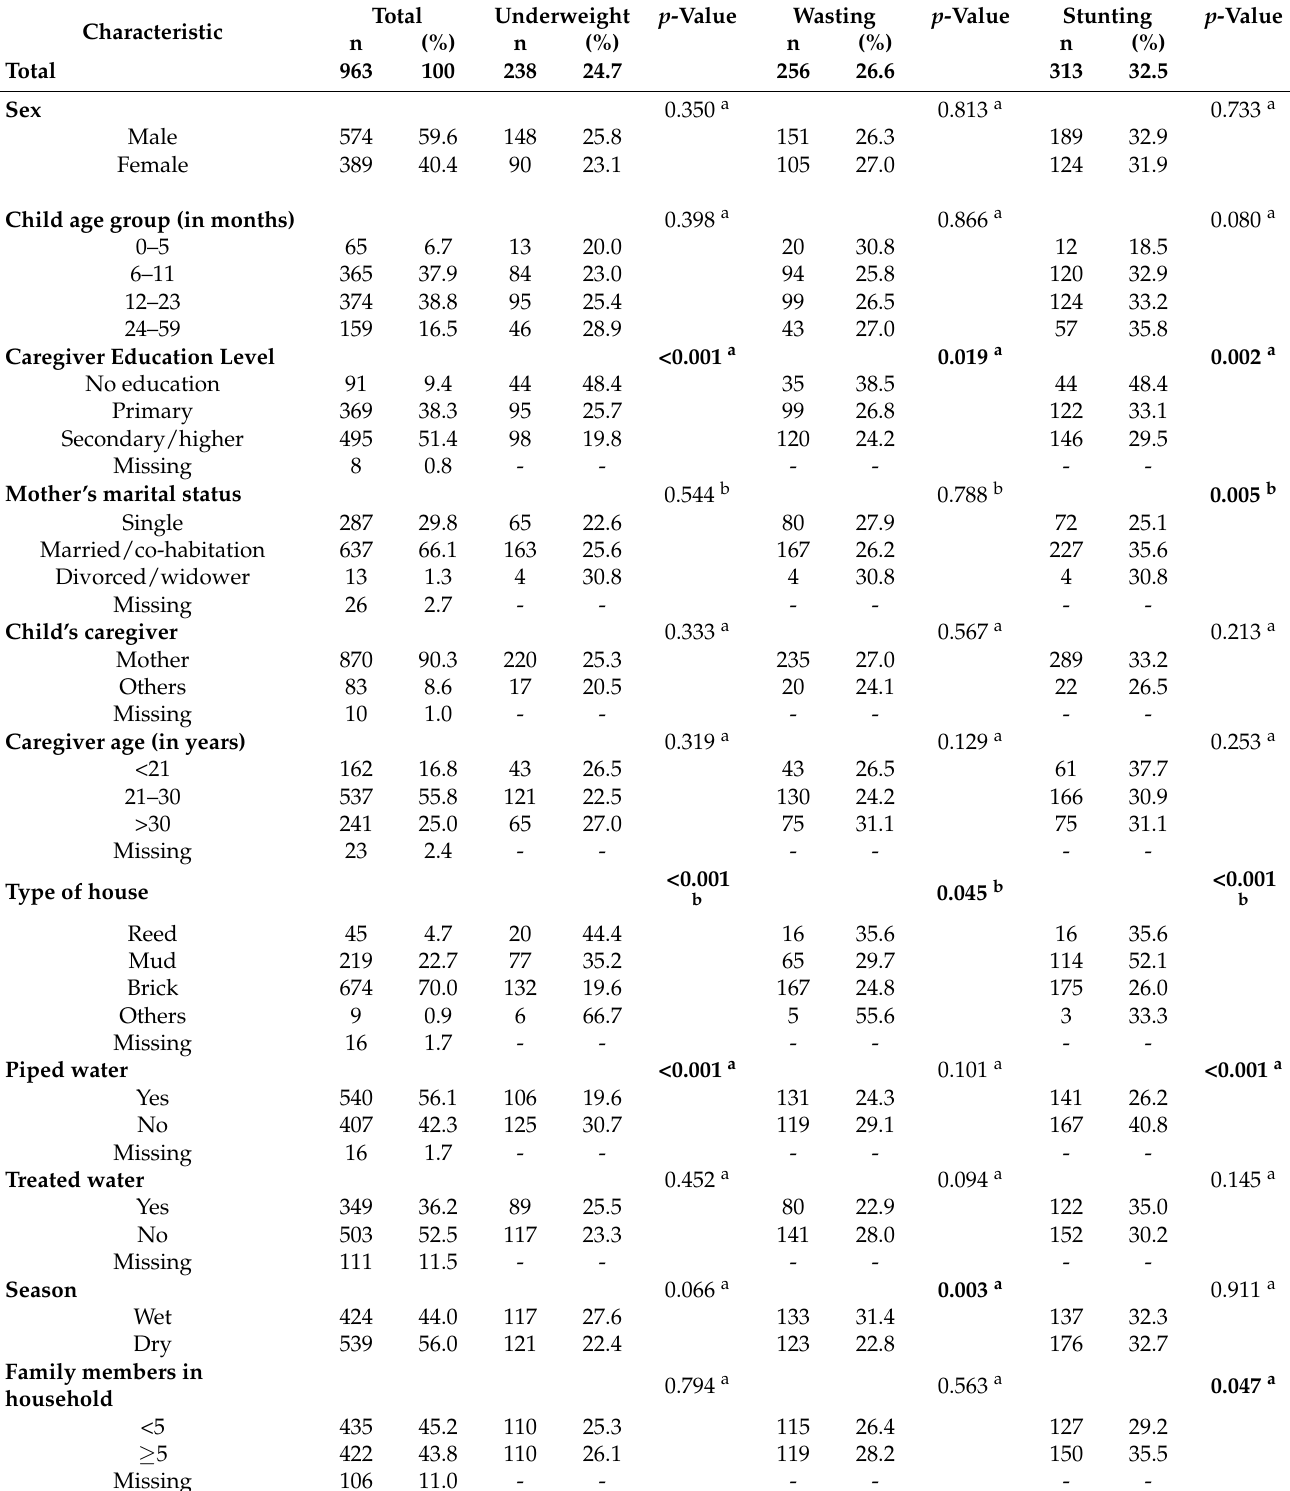
Table 1. Sociodemographic characteristics of the study children for the total sample and frequencies of underweight, wasting, and stunting for each